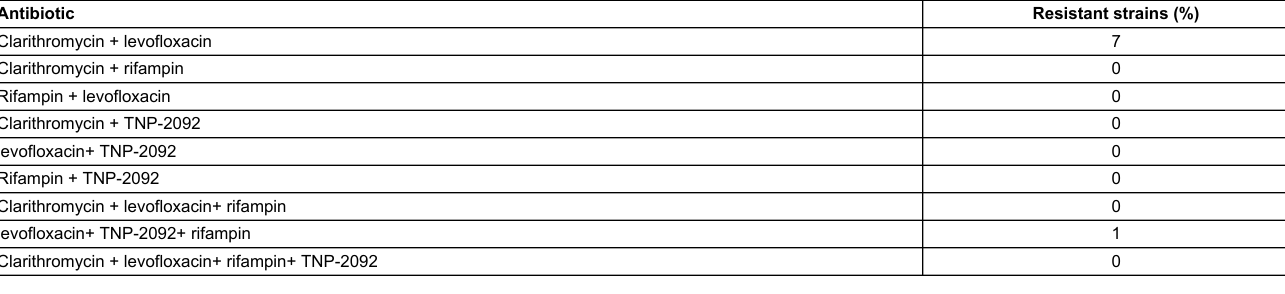
Table 2: Double and multidrug resistance of H. pylori strains. Antibiotic Resistant strains (%) Clarithromycin + levofloxacin